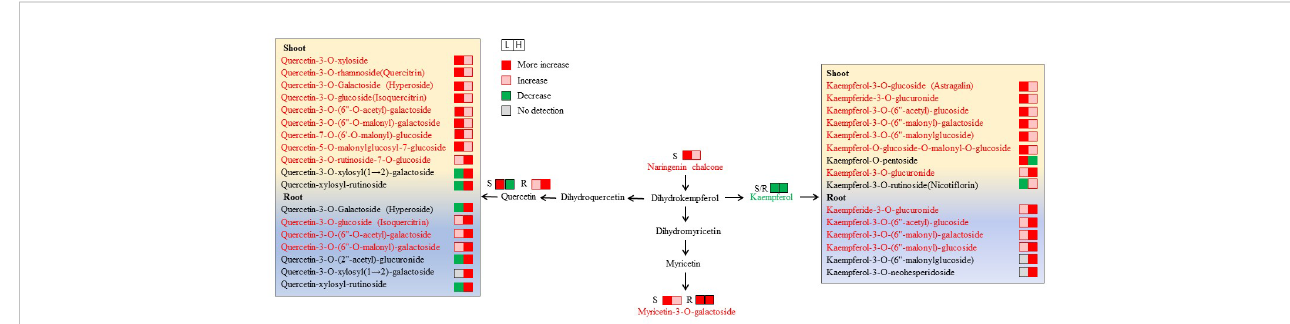
FIGURE 6 Changes in metabolites mapped to the metabolic pathway of fl avone and fl avonol biosynthesis. The metabolites with a red color indicate an increase under both L (50 mM NaCl) and H (300 mM NaCl) condition compared with CK (0 mM NaCl), while the metabolites with a green color indicate a decrease under both L and H condition compared with CK.